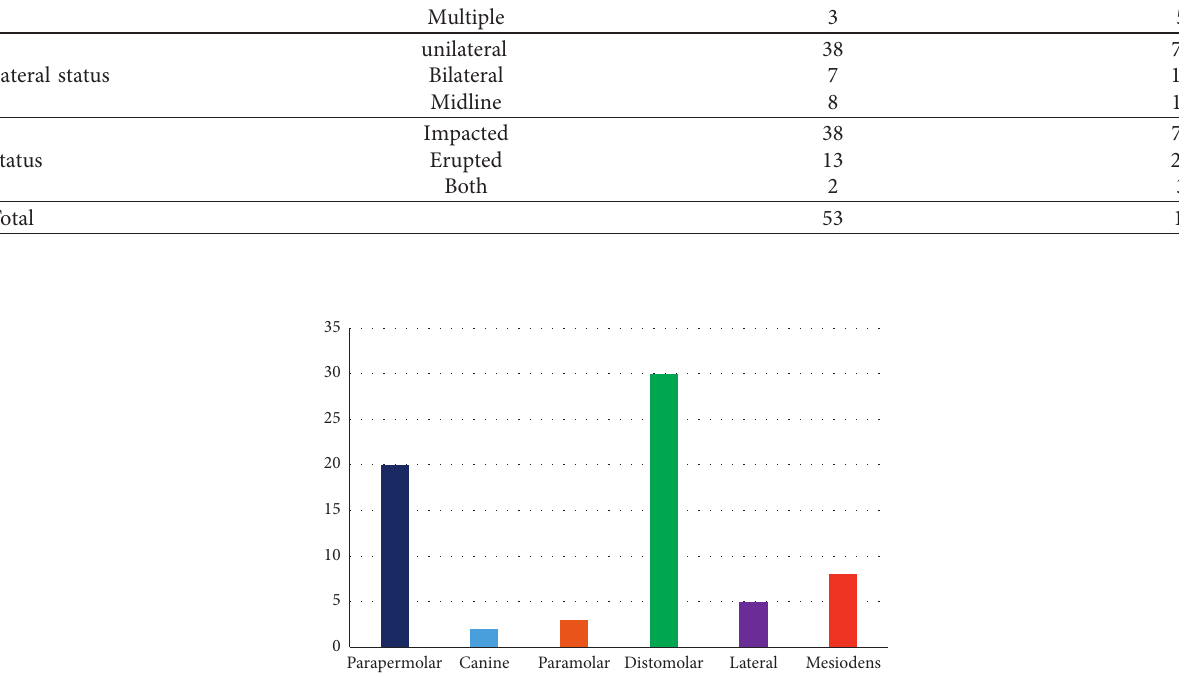
Figure 1: Frequency of supernumerary teeth by location. Table 3: Comparison of the number of supernumerary teeth of men and women according to the type of jaw and the type of extra